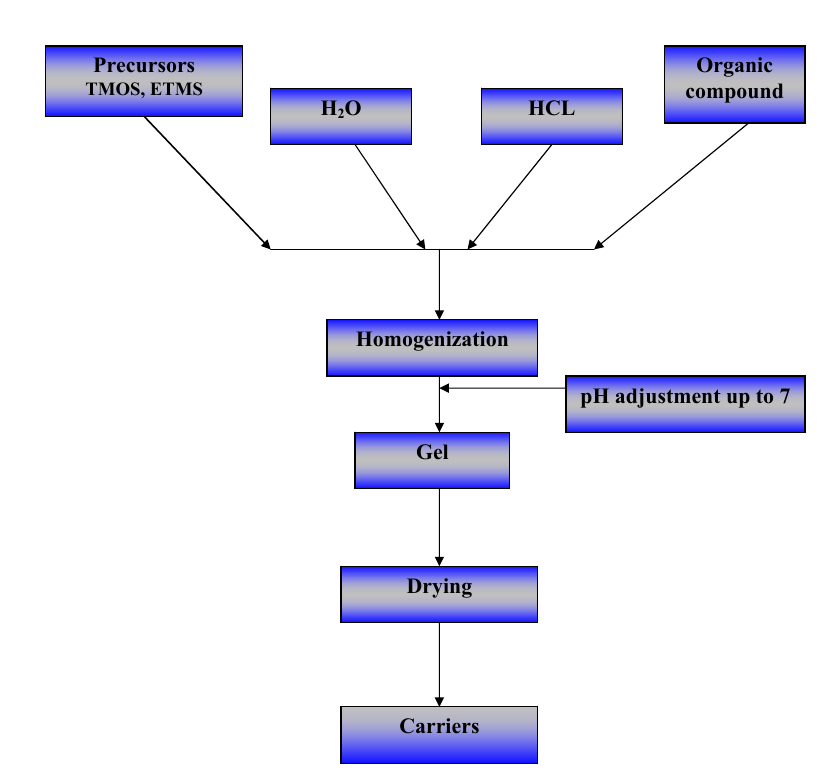
Fig. 1 Fabrication scheme of SiO 2 + Ca alginate hybrid nanocomposite materials.